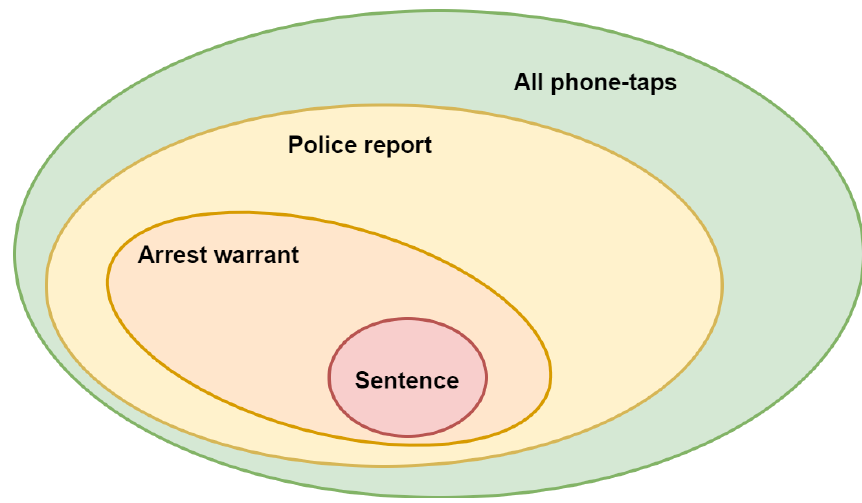
Figure 2. Sampled phone-tapped conversations between criminals in court